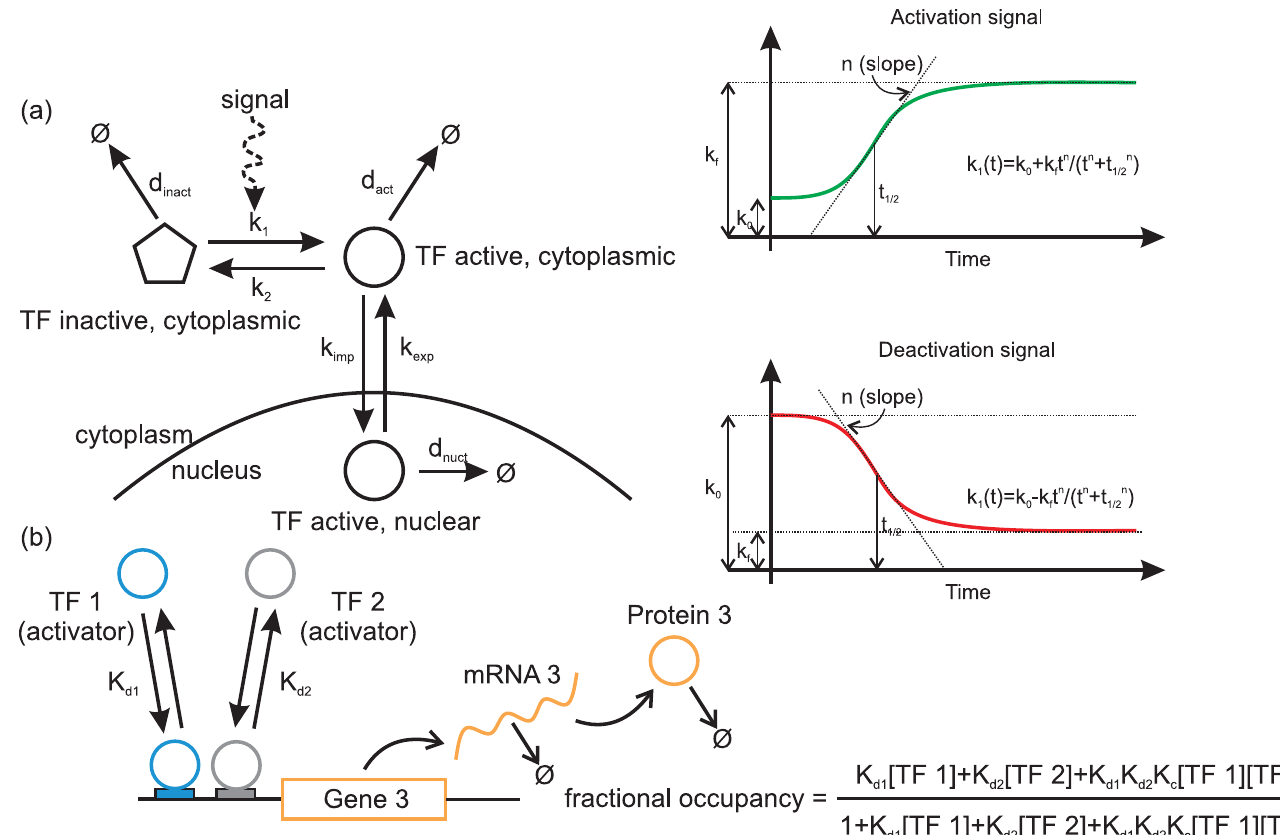
Fig 8. Summary of key modeling assumptions. (a) Assumed TF activation and translocation mechanism.(b) A small example of transcriptional regulation and gene expression modeling. The promoter of Gene 3 has two non-overlapping binding sites, where activators TF1 and TF2 can bind. The fractional occupancy of the promoter can be derived assuming fast equilibrium of binding and unbinding [43]. The factor K c models the cooperative (when > 1) or competitive (when < 1) interaction of TF1 and TF2 in the case TF1 and TF2 are able to bind the promoter simultaneously [44].